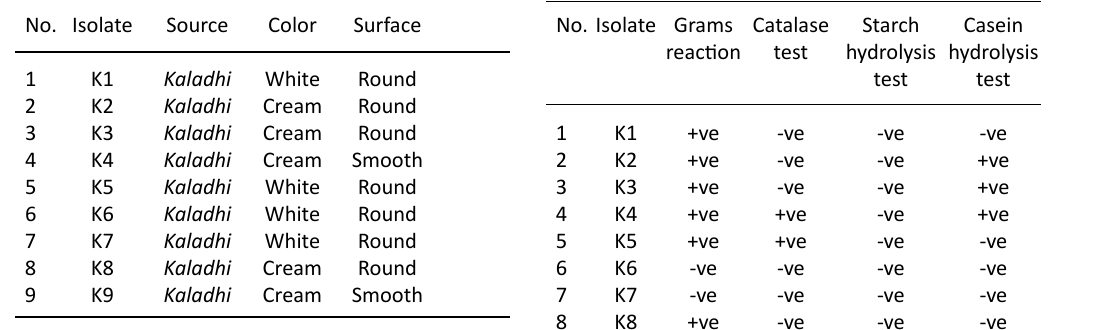
Table 1. Morphological Characteristic of microbial isolates No. Isolate